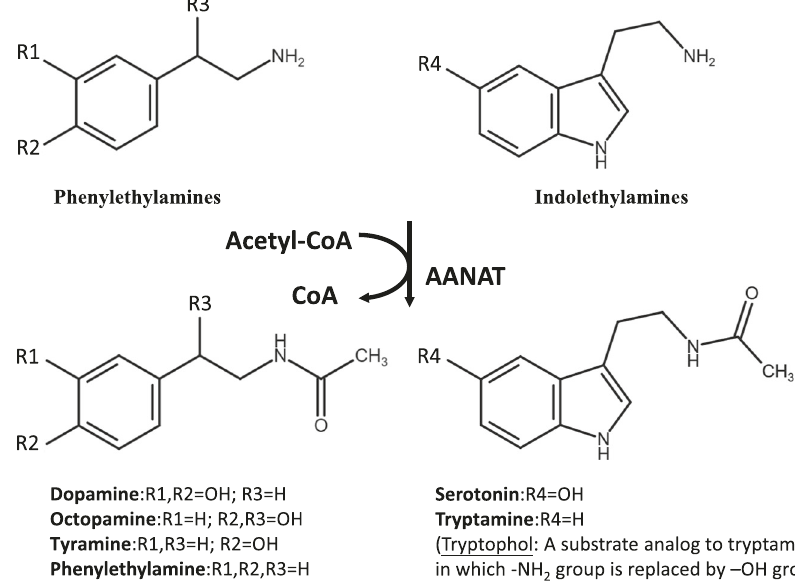
Fig. 1 N-acetylation of monoamines by AANATs. AANATs usually catalyze arylalkylamines, including phenylethylamines and indolethylamines. Dopamine, octopamine, tyramine, and phenylethylamine belong to phenylethylamines, and their structures are based upon the phenylethylamine structure as the core structure with substituents replacing one or more hydrogens. Serotonin and tryptamine belong to